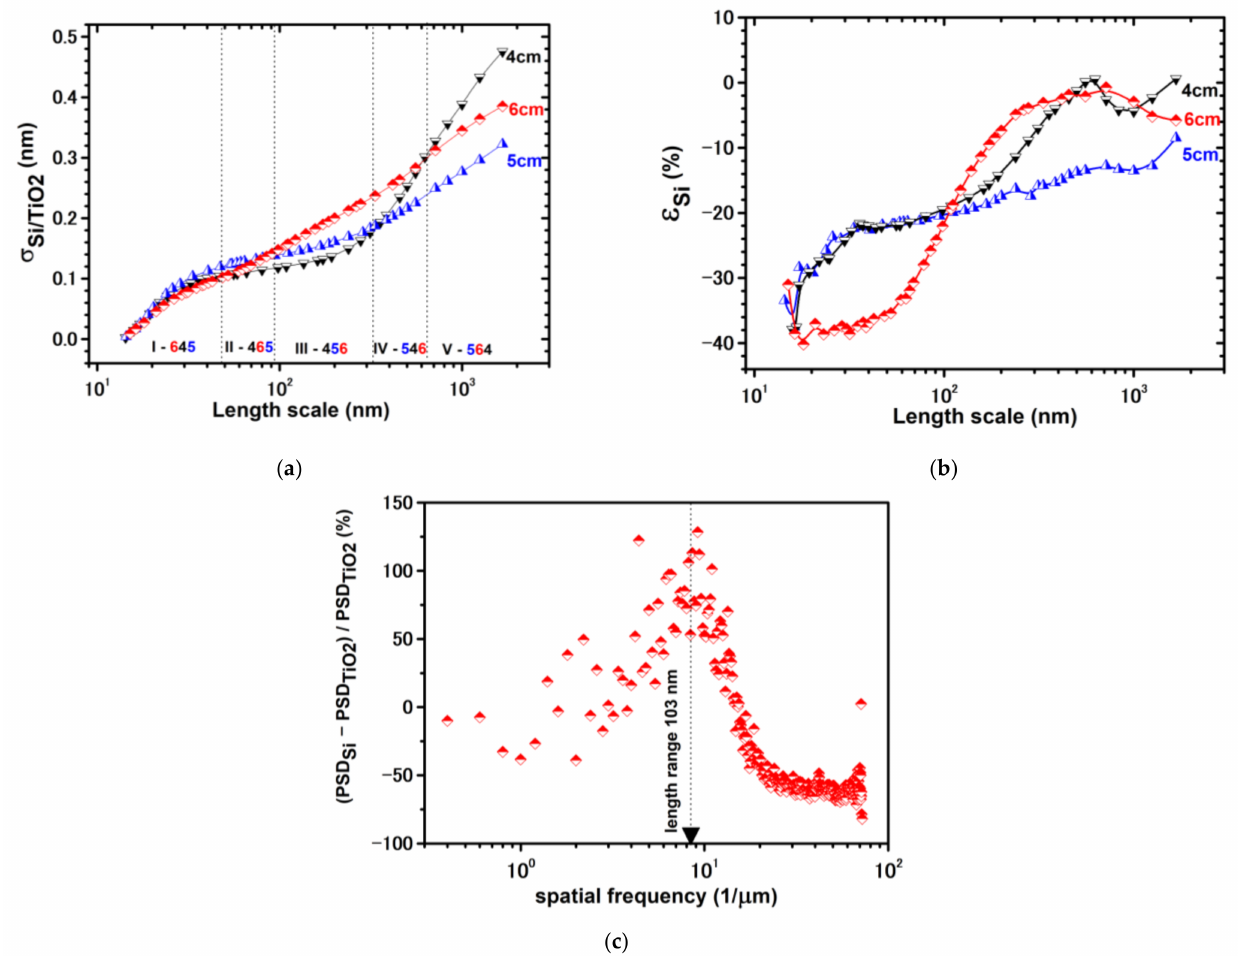
Figure 6. ( a ) Si thin film RMS roughness versus the length scale at different values of d TS . ( b ) The relative roughness variation between Si and TiO 2 thin film surfaces, the last being the substrate coverage of the second layer deposition. The highest slope found in the case of the sample prepared at d TS = 6 cm, close to the crossing point, corresponds to surface features distribution peak at 8.5 µ m − 1 shown in ( c ) that gives the relative variation of PSD amplitude of silicon layer relative to TiO 2 thin film acting as substrate